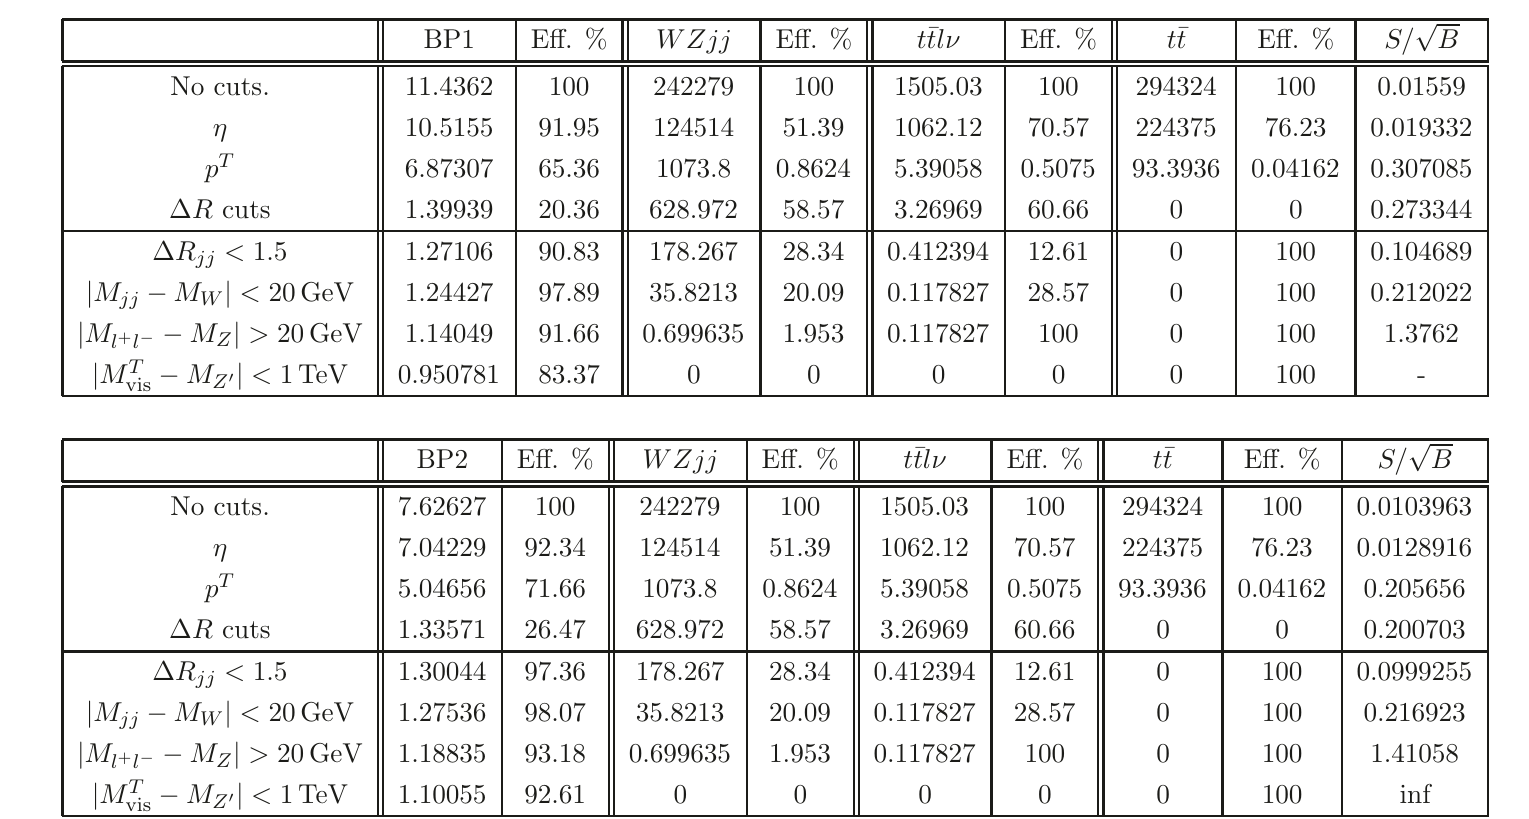
Table 6 . Benchmark point BP1 for the Z ′ -mediator case. Luminosity